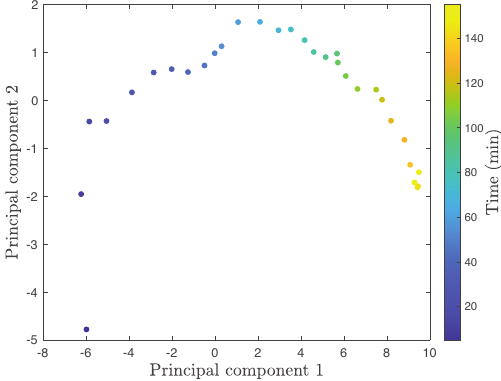
Figure 4. Two principal components of Bearing A _ 2